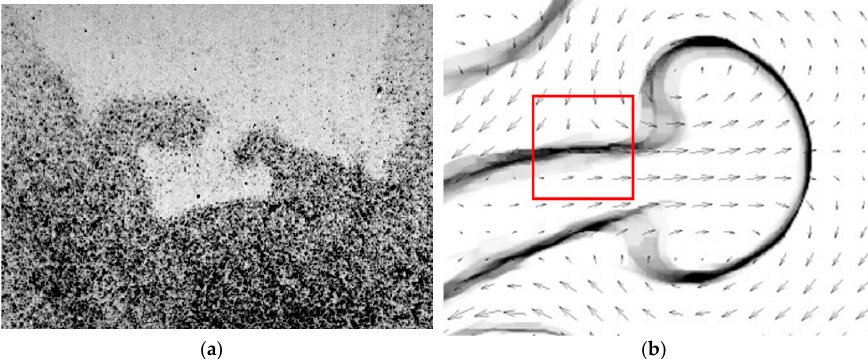
Figure 5. ( a ) Different seeding conditions observed across the reaction zone in a combustion experiment [52]. ( b ) Different flow conditions observed in the mixed-phase PIV results around a mushroom pattern in a magnetic micromixer [22].